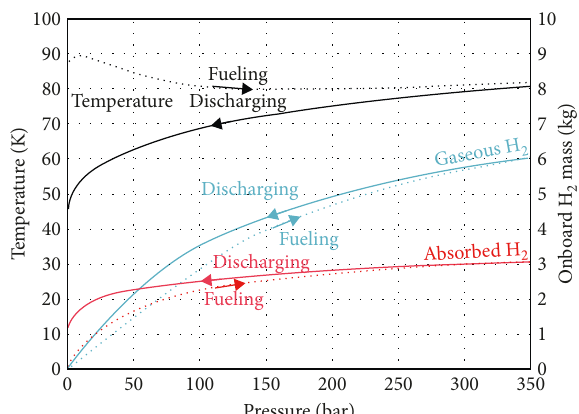
Figure 14: Comparison of physical and chemical storage capacities [275].